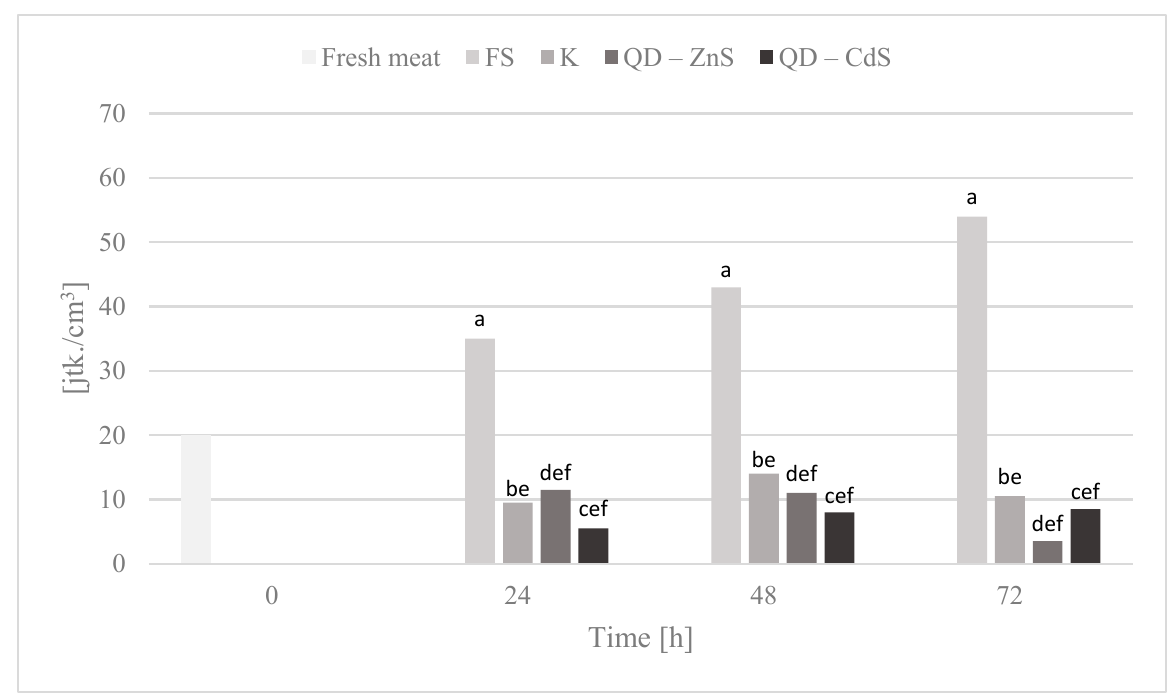
Figure 7. Enterobacteriaceae bacteria count in poultry meat stored under different films at about 4° C. The parameters in the columns denoted with the same letters (a, b, c, etc.) do not differ statistically at the confidence level of p < 0.05.